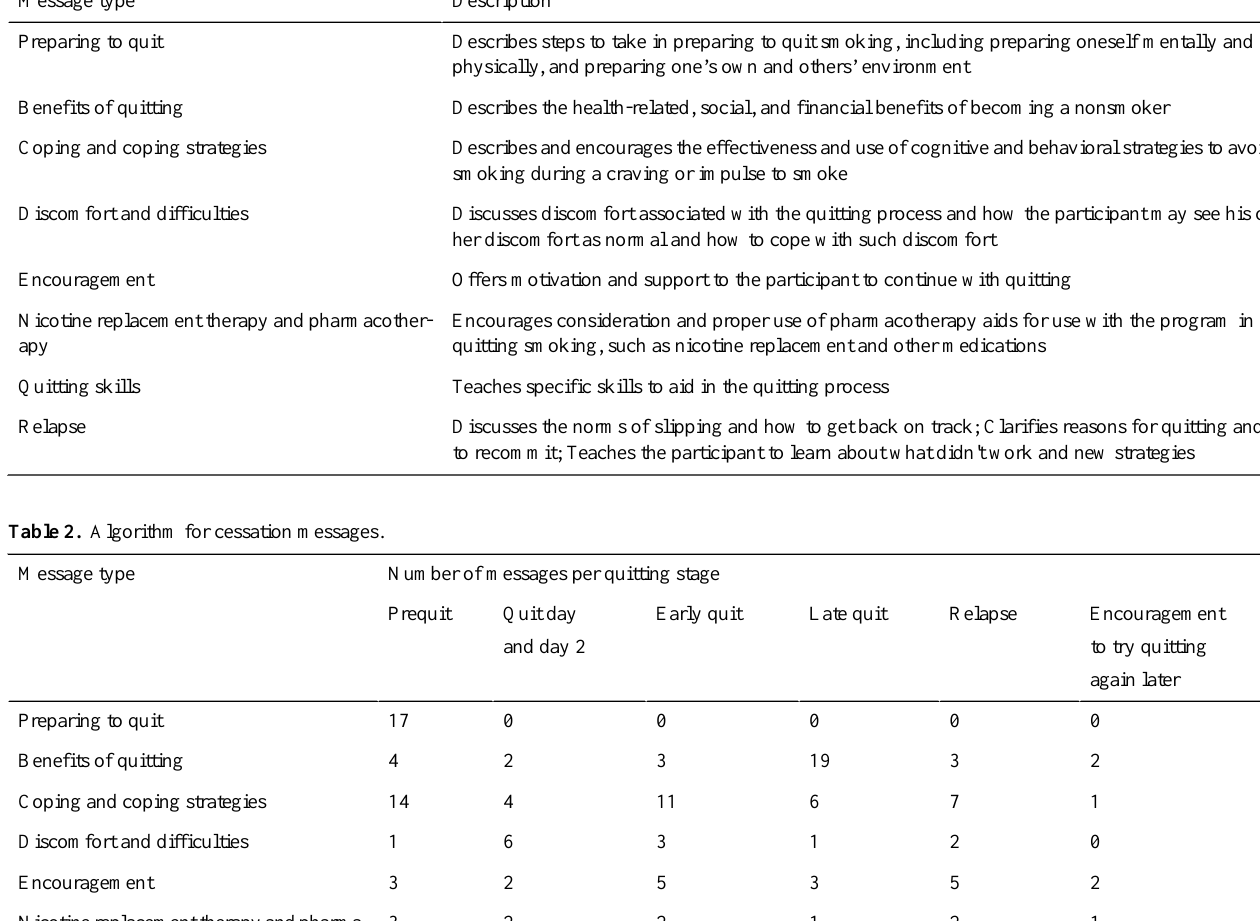
DescriptionMessage